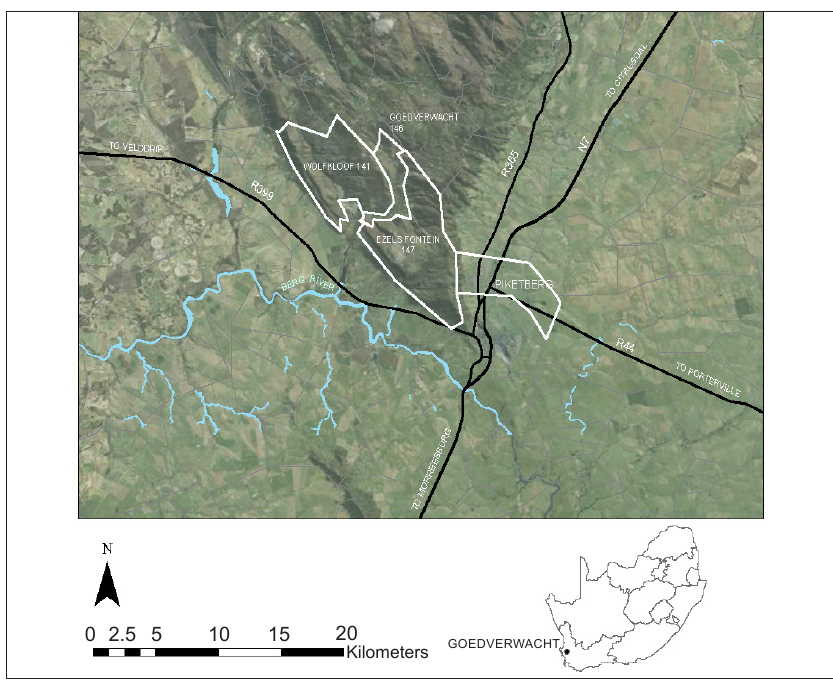
The Goedverwacht Moravian Mission village comprises three farms, Goedverwacht 146, Wolfkloof 141, and Ezels Fontein